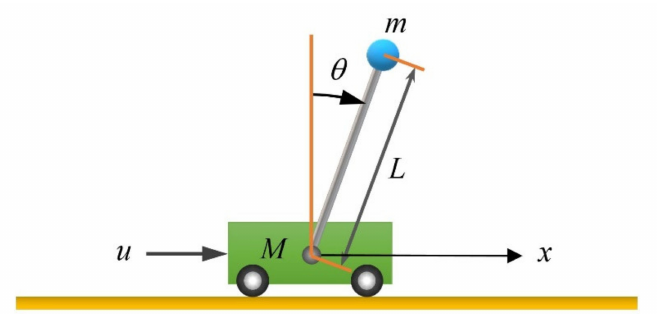
Figure 1. Schematic of an inverted pendulum